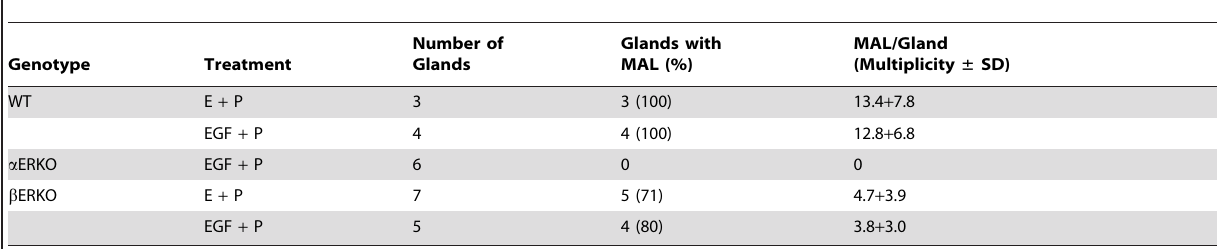
Table 1. Effects of EGF on the induction of DMBA-induced MAL in mammary glands.